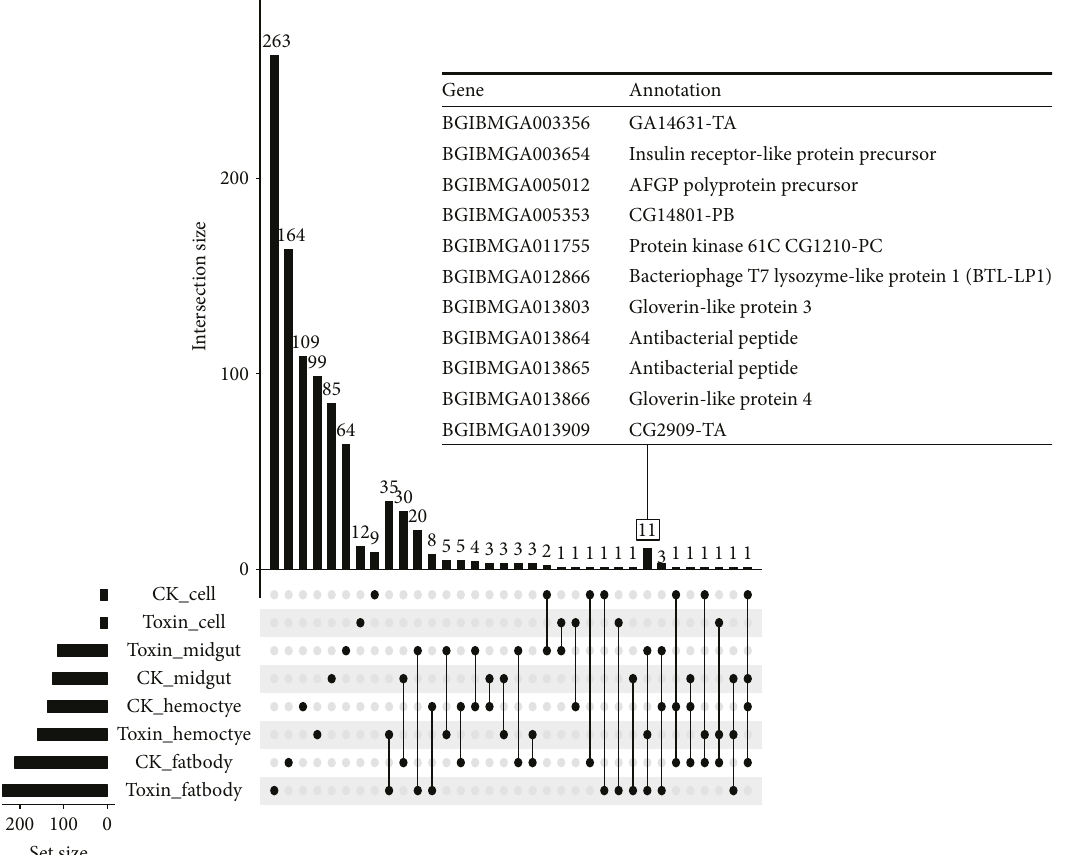
Figure 4: Matrix layout for all intersections of upregulated genes from the four tissues, sorted by size. Dark circles in the matrix indicate sets that are a part of the intersection. The genes common among treated midgut, fatbody, and hemocytes are outlined in the accompanying